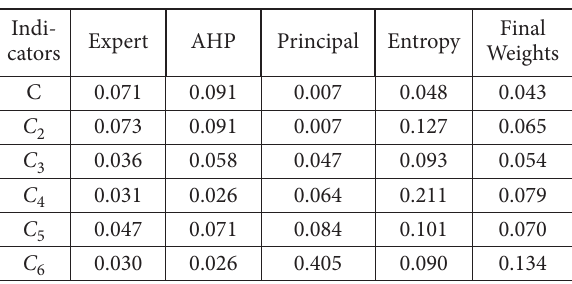
Table 6. The results of weights calculation in